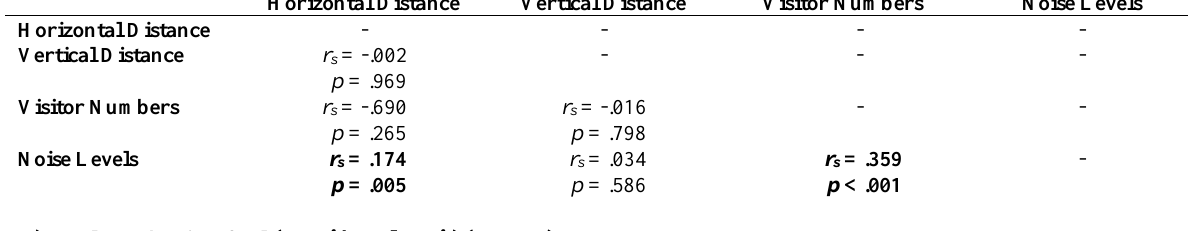
Correlations between Birds’ Horizontal Distance from the Path and Vertical Distance from the Ground against Visitor Numbers and Noise